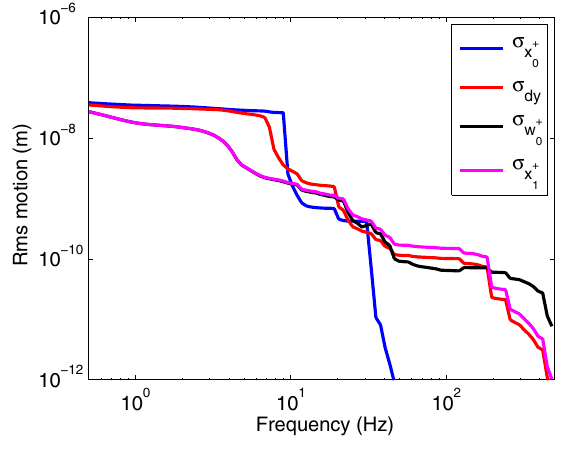
FIG. 7. Integrated rms without technical noise.